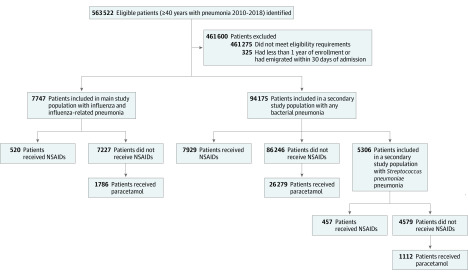
Identification of Study PopulationNSAID indicates nonsteroidal anti-inflammatory drug.